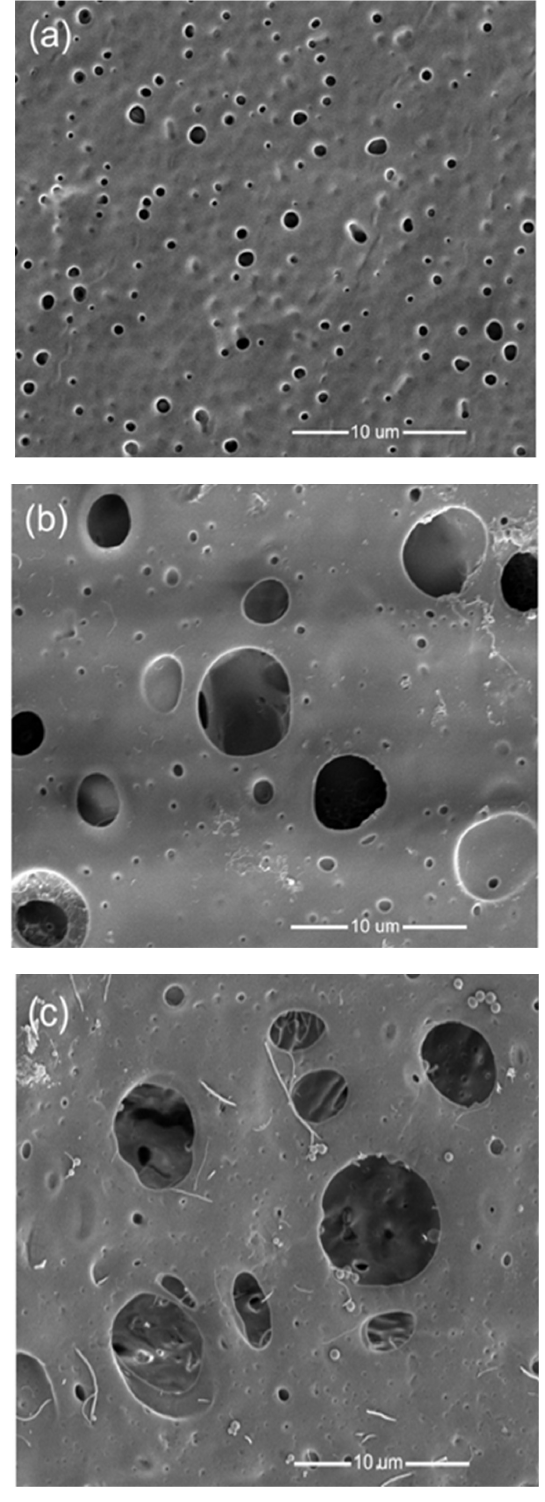
Figure 2. SEM micrographs of ( a ) pristine PS, ( b ) PS/ 1.0 wt. % CCNT, and ( c ) PS/ 1.0 wt. % PCNT membranes.